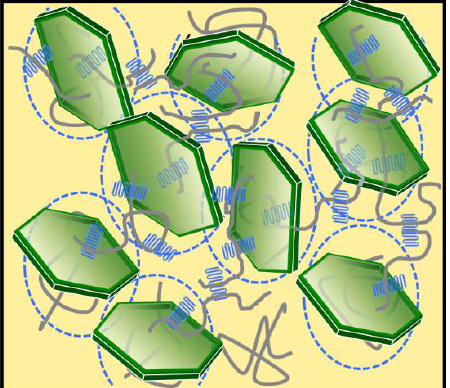
Figure 6. Schematic picture of nylon 6/MMT nanocomposites: a percolation network (physical crosslinked network). Green colored sheets represent MMT nanosheets and the blue dashed line means the effective excluded volume; folded chains in blue are nylon 6 lamellae; Solid line in grey represent nylon 6 chains. Solid grey lines passing through blue lamellar represent part of the chain involved in lamellae.